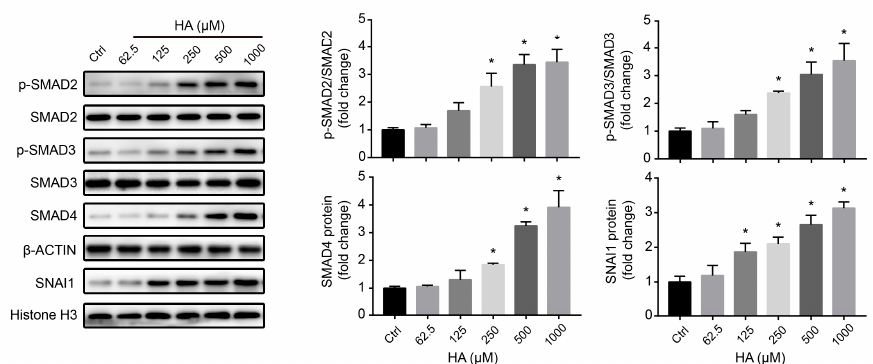
Figure 2. Effects of HA on TGF β /SMAD signaling in HK-2 cells. Expression levels of key proteins in the TGF β /SMAD signaling pathway after treatment with 0–1000 µM HA. Quantification (right) was performed by densitometry. Data are presented as the mean ± standard deviation. * p < 0.05 vs. control (Ctrl) cells. Experiments were repeated three times.